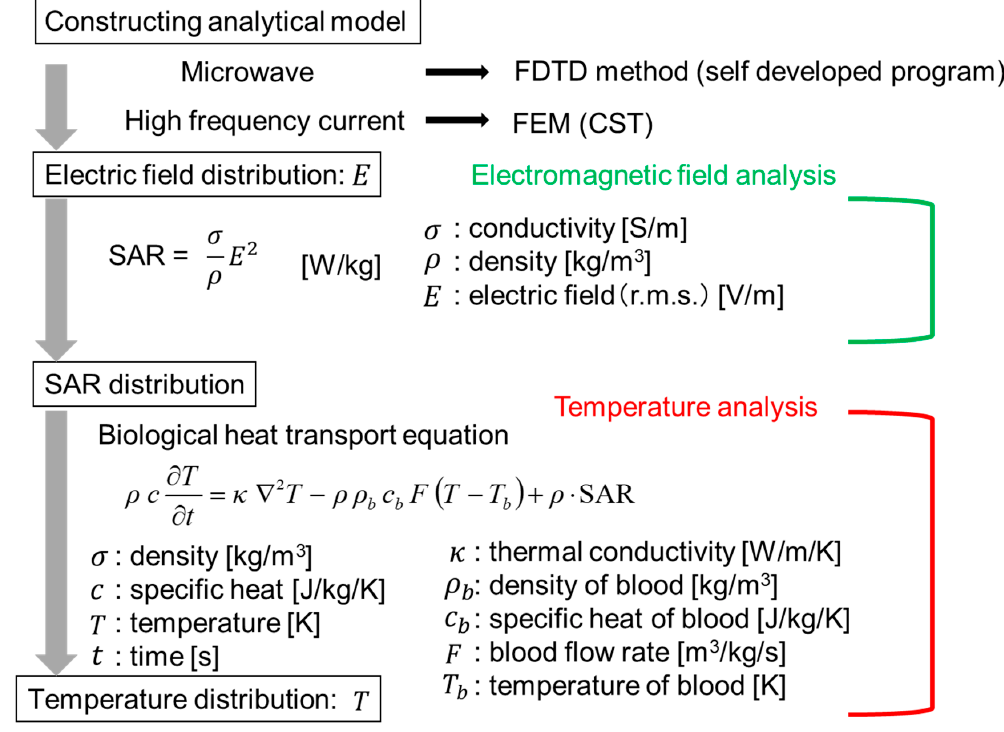
Figure 4. Numerical analysis procedure. FE—finite element.